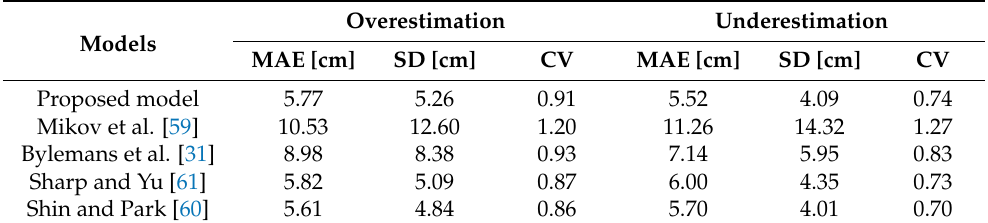
Table 5. MAEs, SDs, and CVs of stride length overestimation and underestimation.